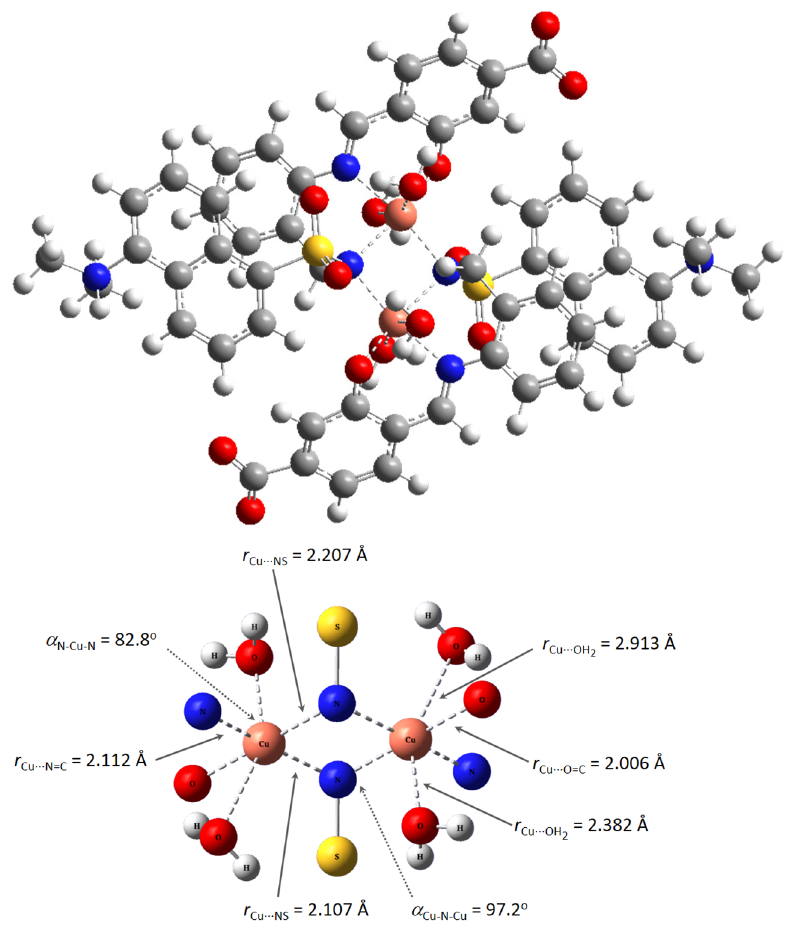
Figure 6. ( Top ): M062X/6-31G* optimized structure of Cu 2 (HL) 2 (H 2 O) 4 . ( Bottom ): Some bond distances and angles in the coordination environment of the copper ions.